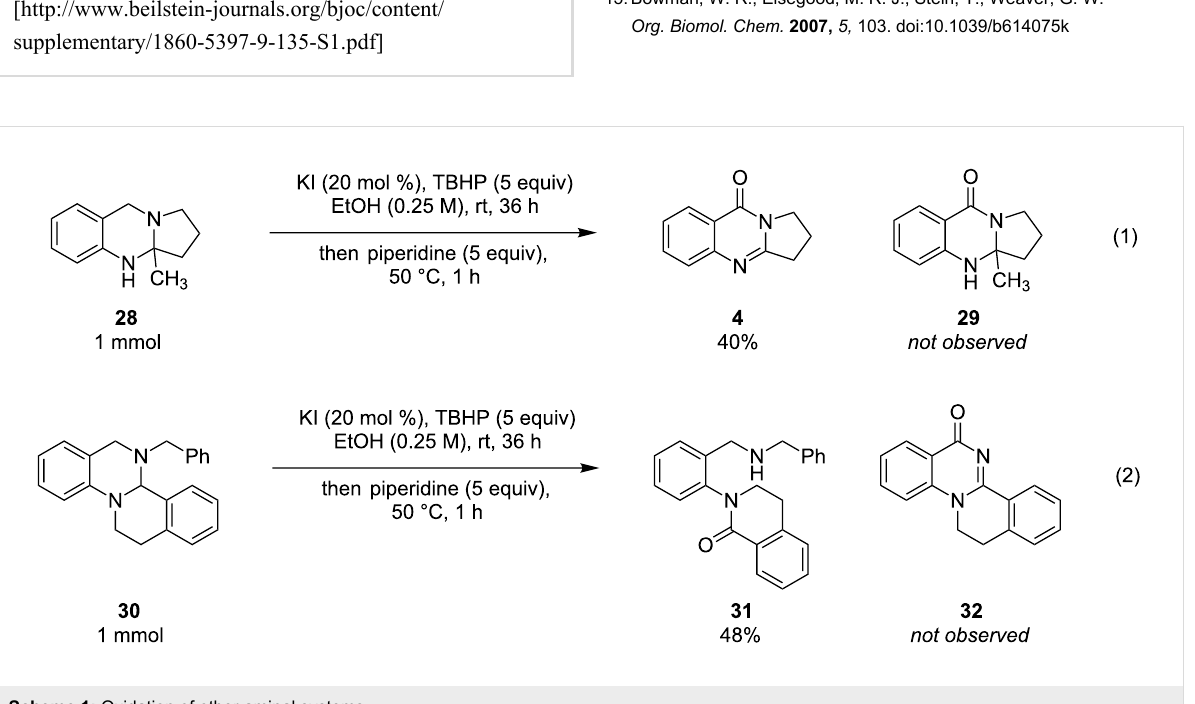
Scheme 1: Oxidation of other aminal